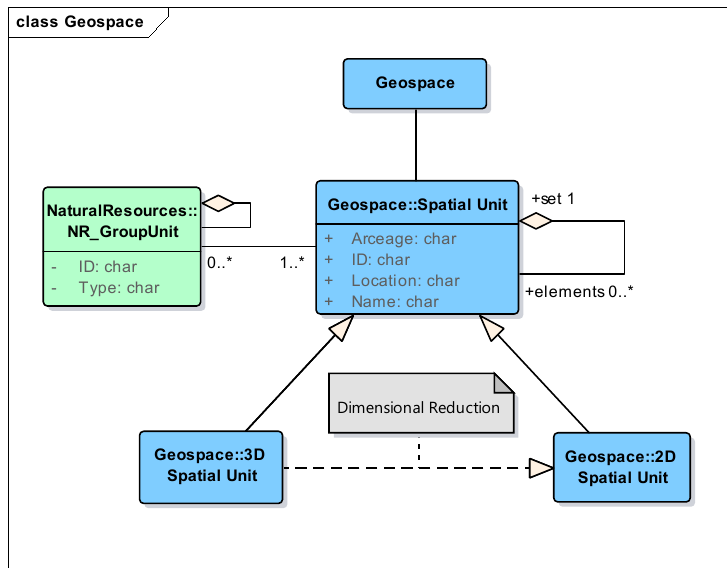
Figure 17. Geospace class. Figure 17. Geospace